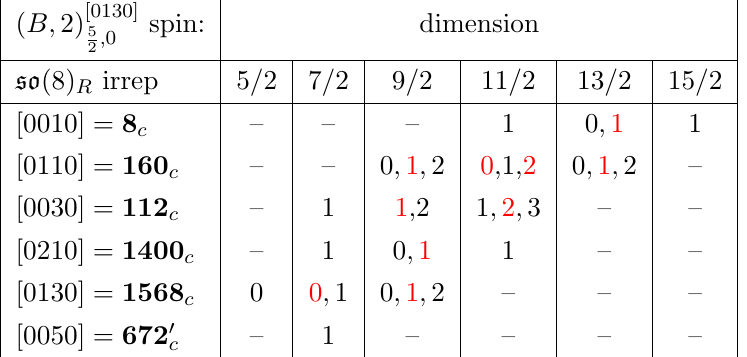
Table 14 . All possible conformal primaries in S 2 (cid:2) S 3 corresponding to the ( B; 2) [0130] formal multiplet.